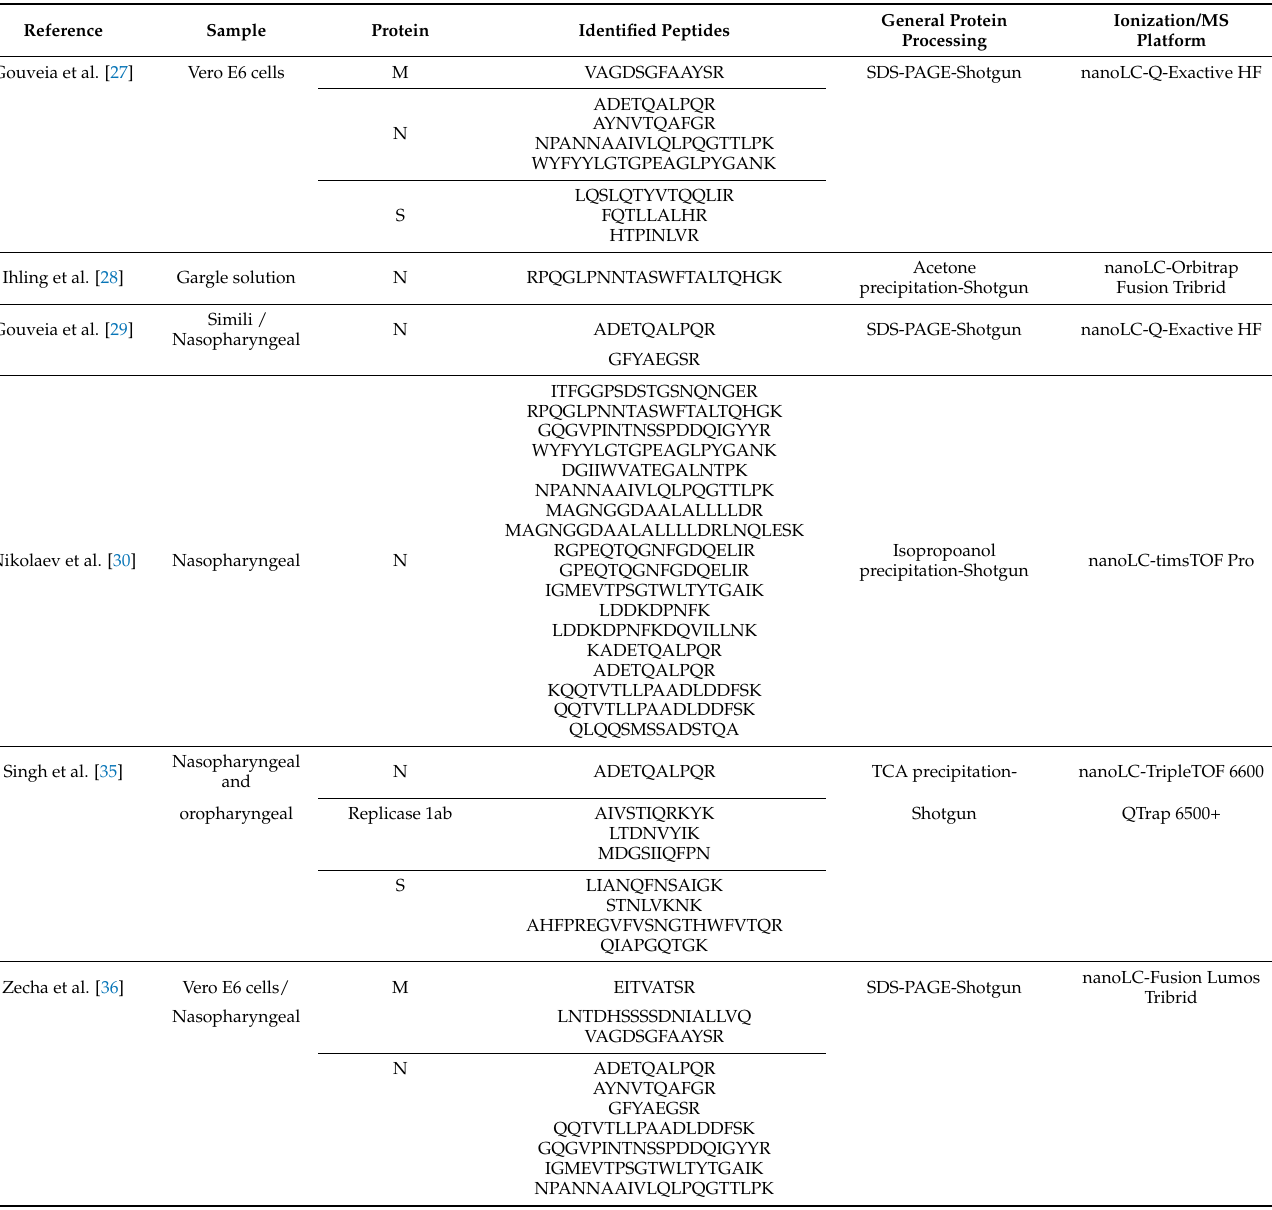
Table 1. Proposed peptides as candidates to be used in diagnostic methods for SARS-CoV-2/COVID- 19 through targeted